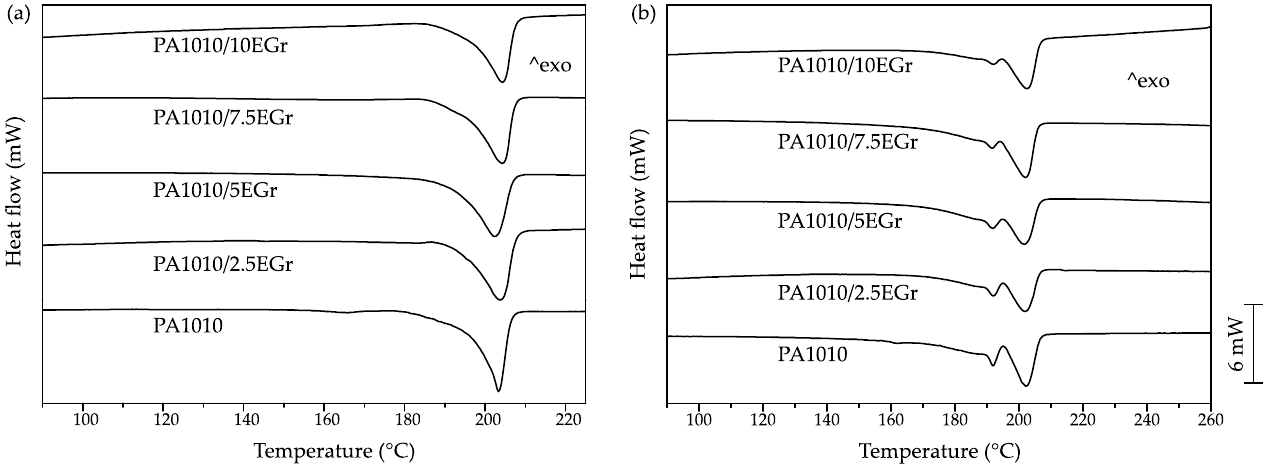
Figure 3. Differential scanning calorimetry (DSC) thermograms of PA1010/EGr composites, ( a ) first heating cycle and ( b ) second heating cycle. Table 3. Thermal parameters of the composites with different amounts of expandable graphite in terms of: melting temperature (T m ), normalized melting enthalpy ( ∆ H m ) and degree of crys- tallinity (X c